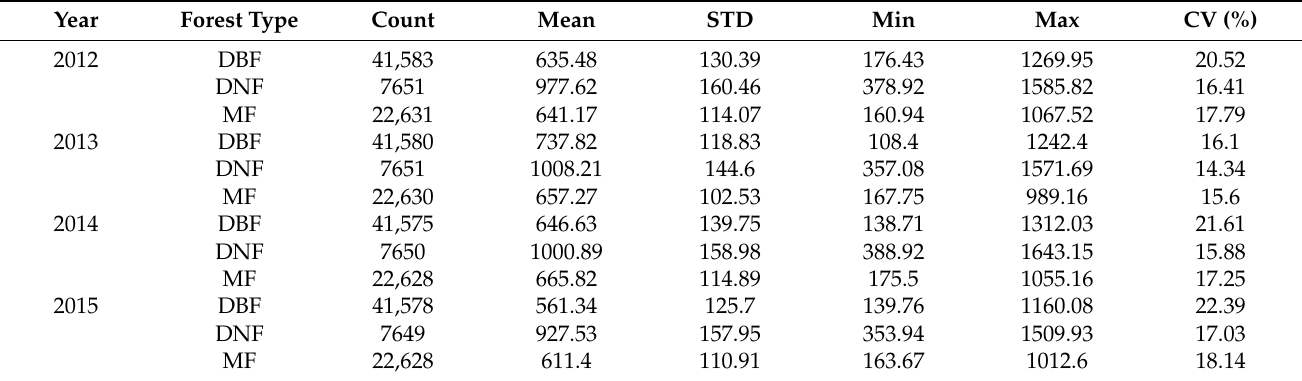
Figure 3. The distribution of GPP in the Greater Khingan Mountains in Inner Mongolia from 2012 to 2015. The highest value for DBF GPP was in 2013 and the highest value for DNF and MF GPP was in 2014. Table 2 shows the descriptive statistical results of the annual mean value of GPP for different forest types, including year, forest type, number of pixels (Count), mean (Mean), maximum value (Max), minimum value (Min), standard deviation (STD), and coefficient of variation (CV). Table 2. GPP statistical results of the MOD_17 model simulation after